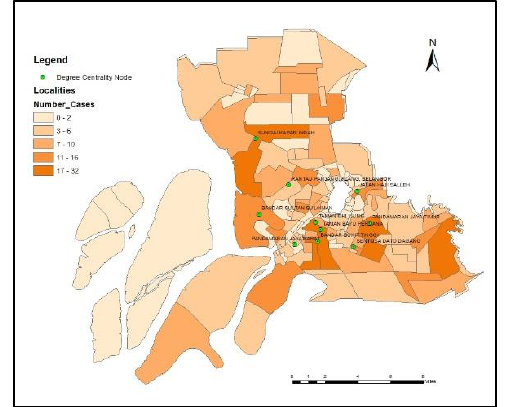
Figure 12. The relationship of degree centrality node and TB hotspot area.